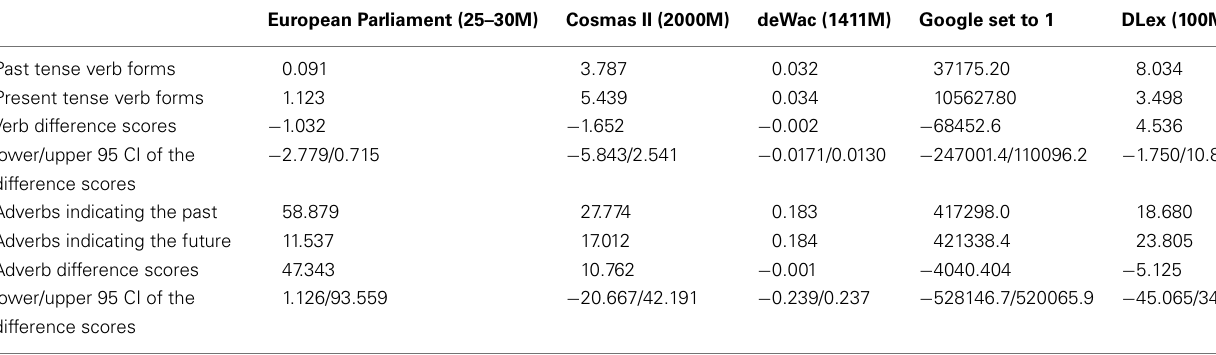
Table 4 | Normalized frequency counts for the verb forms and adverbs in our materials averaged across the